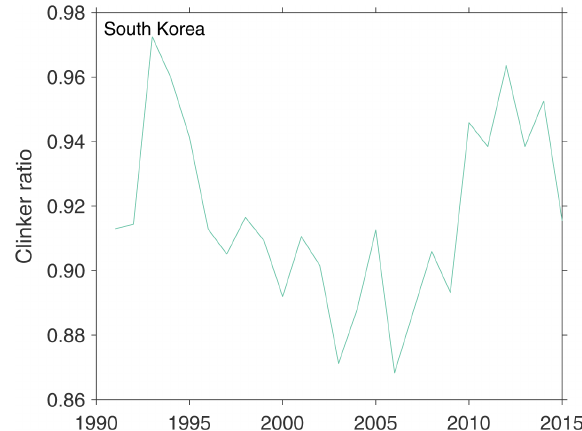
Figure C22. Revised cement emissions for Jamaica.